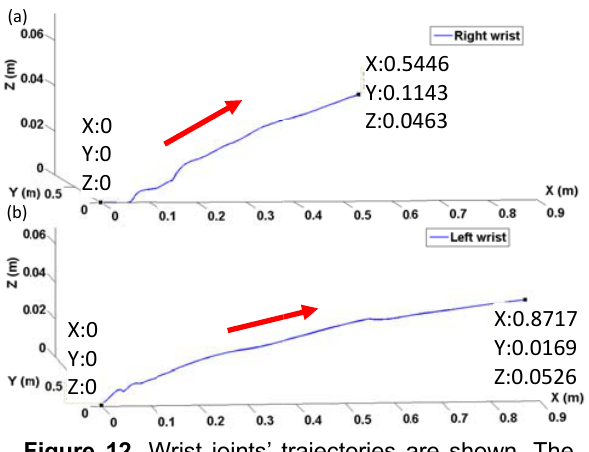
Figure 12. W short distanc knee joints d ankle joints.